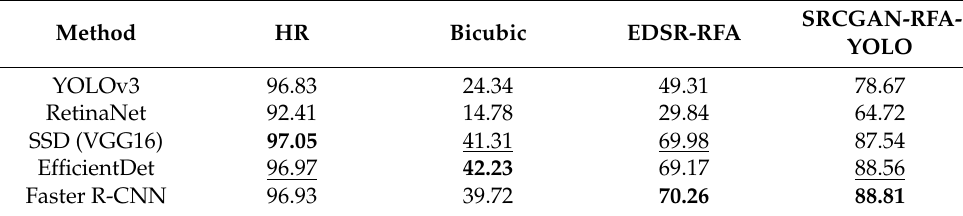
Table 7. The impact of changing the detection networks on AP with an IoU of 0.10 (for a scale factor of